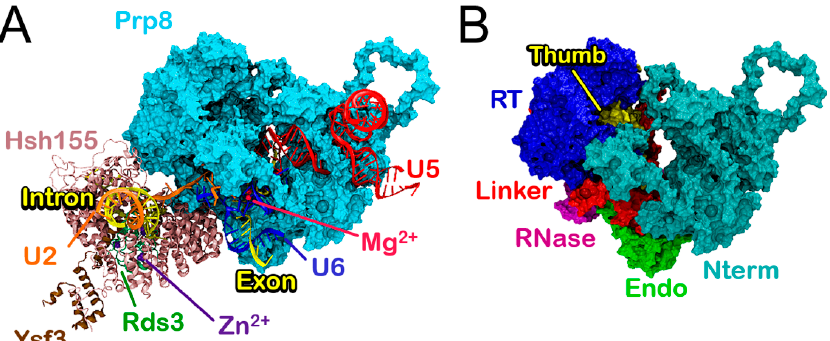
Figure 2. Spliceosome Bact model built on the yeast Saccharomyces cerevisie B act cryo-EM structure (Protein Data Bank code: 5GM6) [18]. ( A ) Proteins (Hsh155 (light pink), Rds3 (green) and Ysf3 (brown) and RNAs (U2 (orange), U5 (red), U6 (blue), intron, and exon (yellow) are depicted as cartoons, whereas Prp8 is shown as a cyan surface. Mg 2+ and Zn 2+ ions are represented as light-red and violet spheres, respectively. ( B ) Domain subdivision of Prp8 into Nterm (dark cyan), RT (blue), Thumb (yellow), Linker (red), Endo (light green), and RNase (purple) shown as surfaces. The structural convergence of this model was reached within 580 ns for all replicas (Figure S1).